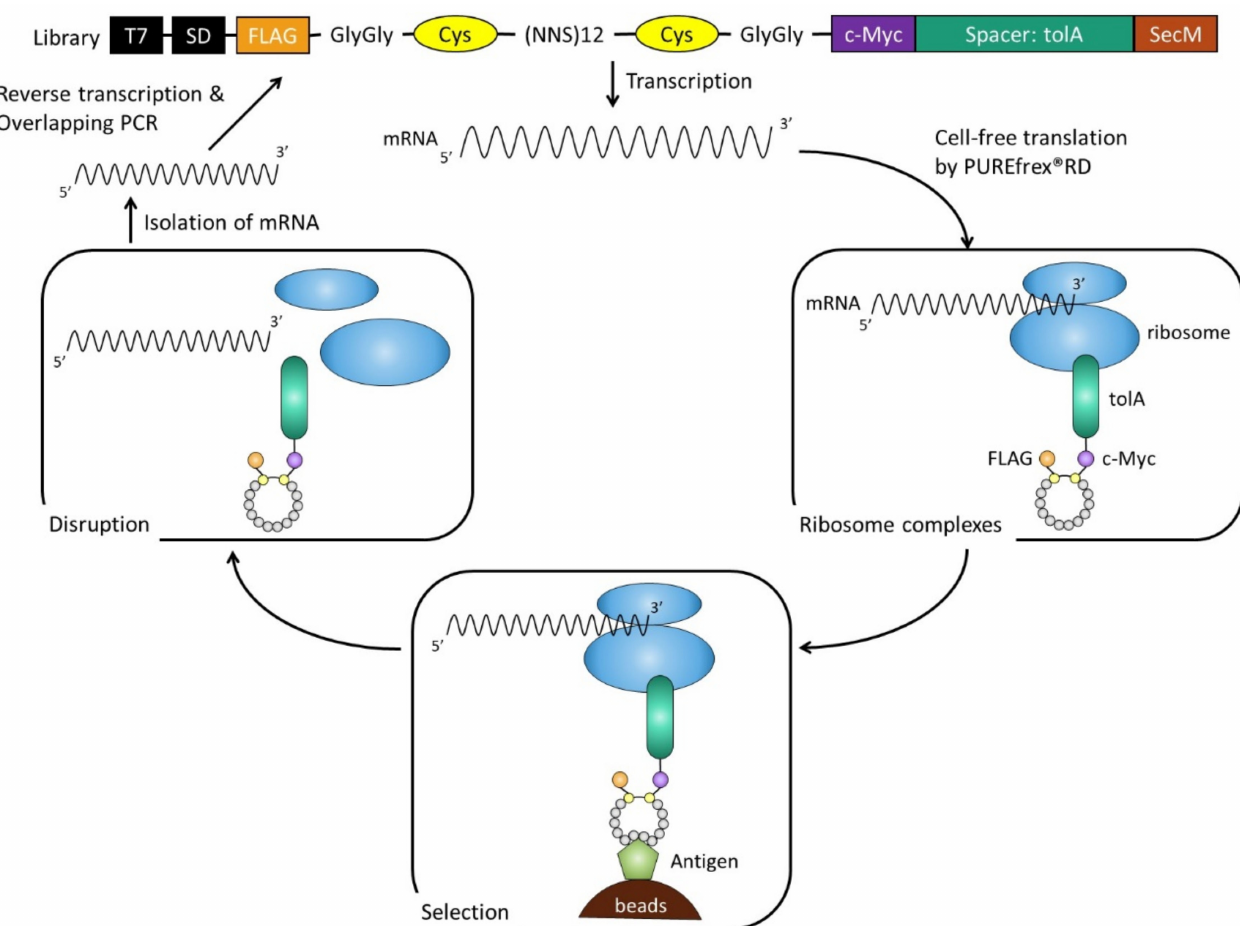
Figure 1. Ribosome display cycle. DNA encoding in library was first transcribed, and resulting mRNA was translated by PURE frex ® RD cell-free translation system optimized for ribosome display, to give rise to mRNA–ribosome–peptide complexes through SecM arrest sequence, which acts within the ribosomal exit tunnel to stop translation. mRNA–ribosome–peptide complexes were used directly for selection against an immobilized target on beads. After selection, retained complexes were disrupted by the addition of EDTA. mRNA was isolated, reverse transcribed, and amplified for the next